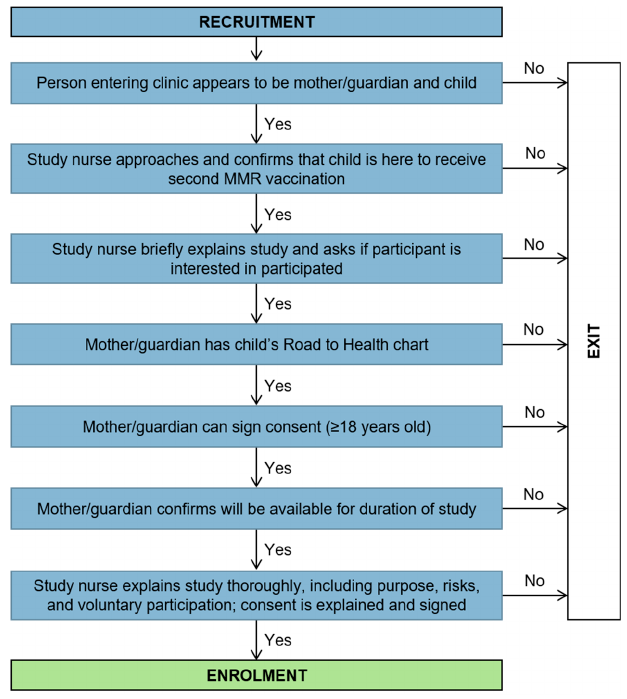
Figure 3. Recruitment stage flow chart.